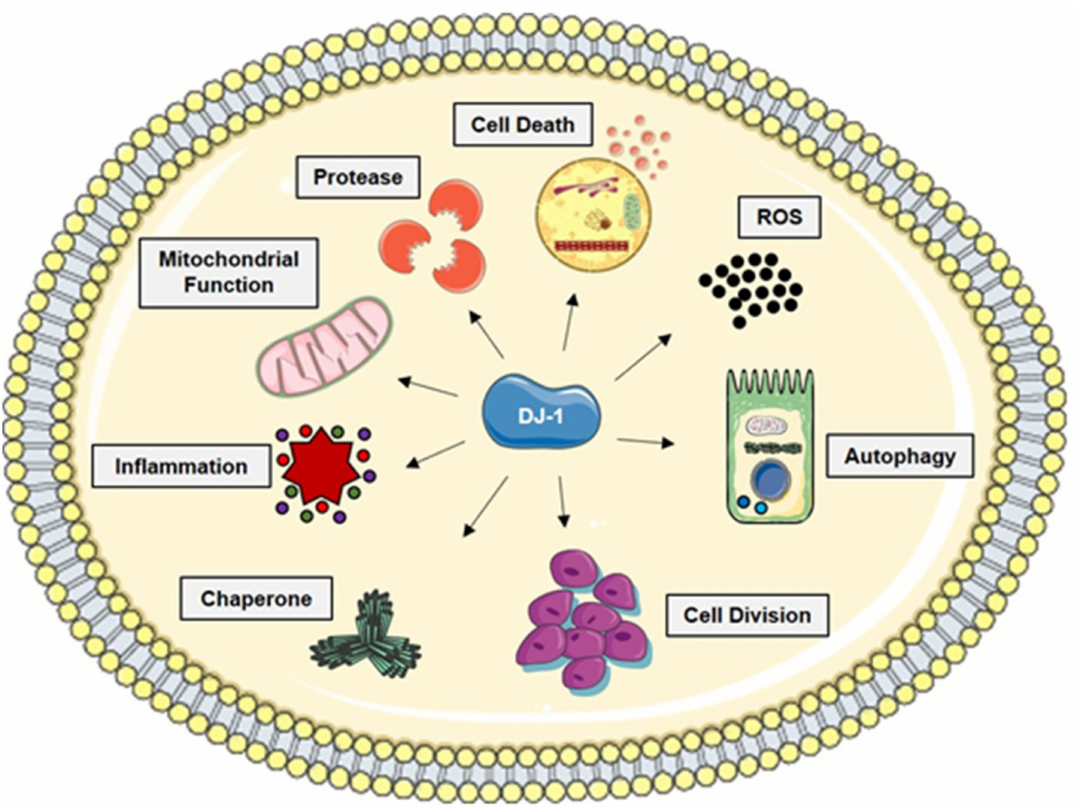
Figure 1. Schematic diagram of the various pathways regulated by DJ-1. Representation of the different DJ-1 activation pathways. DJ-1 possesses chaperone and protease activities and regulates pathways involved in cell death, ROS production, autophagy, cell division, and